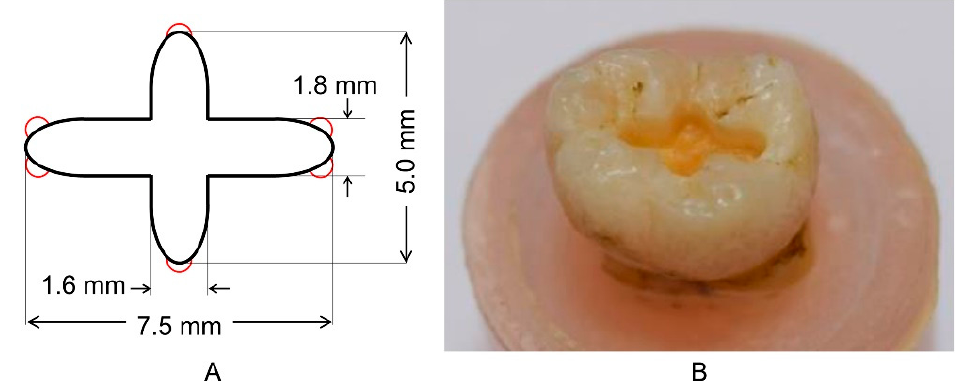
Figure 1. Cavity for filling dental amalgams. ( A ) dimension of the cavity. Red circles indicate dentin undercuts, ( B ) cavity prepared in the occlusal plane of a molar.